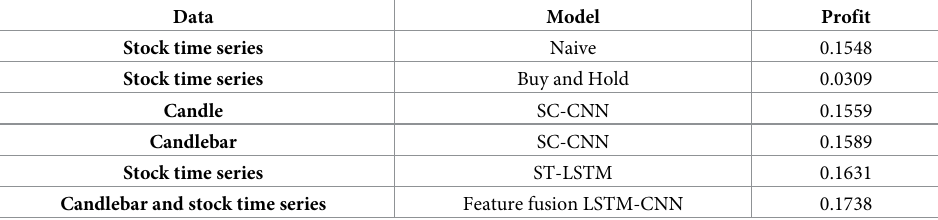
Table 6. Comparison of out-of-sample profit of trading strategies based on five different